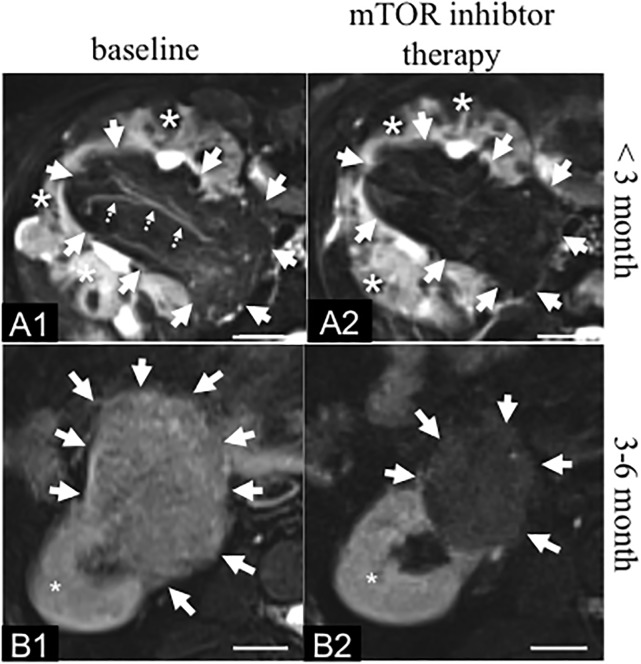
Fatty transformation of angiomyolipoma in TSC patients after initiation of mTOR inhibitor therapy.A: Example of a large AML at the central part of the right kidney in a 33 year-old female TSC patient. A1: At baseline a heterogeneous AML with a mixed-signal on the T2 fat saturated MR sequence (solid arrows) could be visualized. Slow flowing blood in a small vessel (dotted arrows) appears hyperintense on the fat saturated sequence. The unaffected “healthy” kidney tissue is also visualized with a hyperintense signal (*). A2: 2.5 months following the initiation of the mTOR inhibitor therapy a reduction in the overall signal of the AML on the T2 fat saturated sequence can be visualized. The vessel, which was visible at baseline (A1: dotted line) cannot be delineated anymore. Additionally, a reduction of size of the AML can be visualized. This case represents a good example of how difficult it can be to clearly quantify a size reduction in a heterogenous AML following the initiation of mTOR therapy. B: Example of a AML at the caudal part of the right kidney in a 45 year-old male TSC patient. B1: At baseline a heterogeneous relatively bright angiomyolipoma could be visualized on the T2 fat saturated sequence (arrows). The unaffected “healthy” kidney tissue is visualized with a homogenous hyperintense signal on the T2 fat saturated sequence (*). B2: 3 to 6 months following the initiation of the mTOR inhibitor therapy, a clear reduction in the signal on the T2 fat saturated sequence as well as in the size of the angiomyolipoma is visualized. The signal of the healthy kidney tissue does not change following the initiation of the therapy (*). MRI: Magnetic Resonance Imaging. Fatsat: Fat saturated. Scale bar: 1.5 cm.